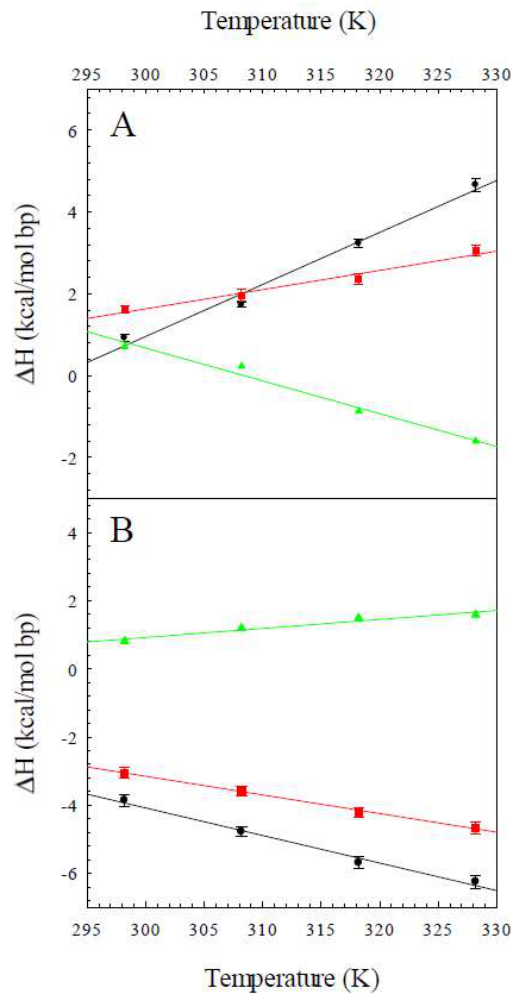
Figure 2. Plots of ΔH obs , Z8A (black), ΔH obs , Z8B (red) and ΔH conf (green), calculated using Equation (2), versus temperature for the titrations with ( A ) Na + or ( B ) [Co(NH 3 ) 6 ] 3+ . The solid lines are the least squares linear fits and the slopes of those lines yield the difference in heat capacities, ΔC p , of the DNA oligomers between the initial state to the final state. These values can be found in Table 2. Table 2. The change in heat capacities (ΔC p ) for of Z8A and Z8M resulting from their titrations with either Na + or [Co(NH 3 ) 6 ] 3+ .